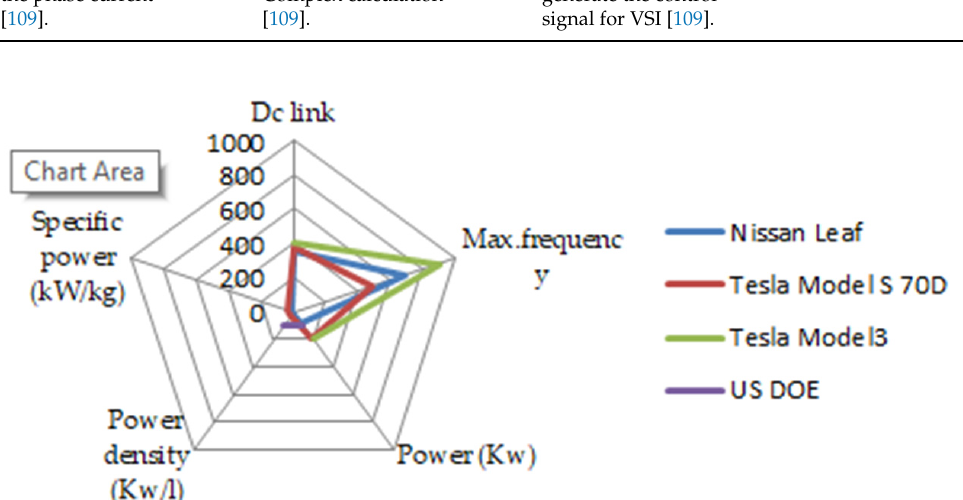
Figure 8. Spiderchart represents the performance comparison of inverter used in real-time appli- cations.